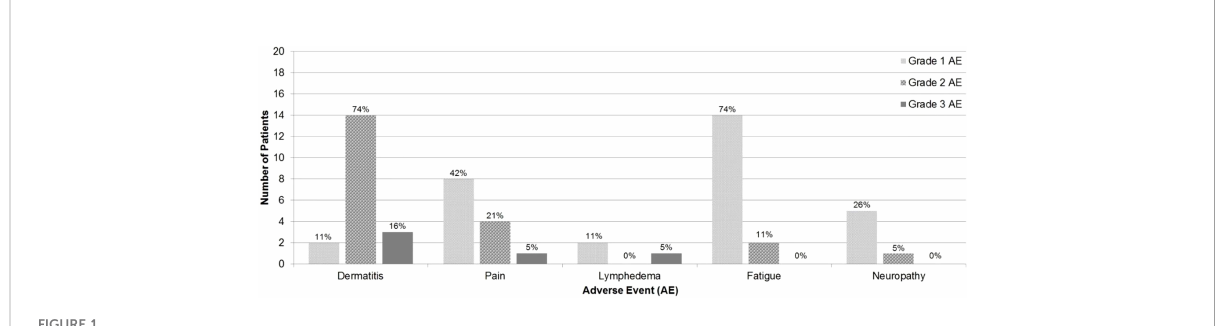
FIGURE 1 Maximum grade of adverse events by